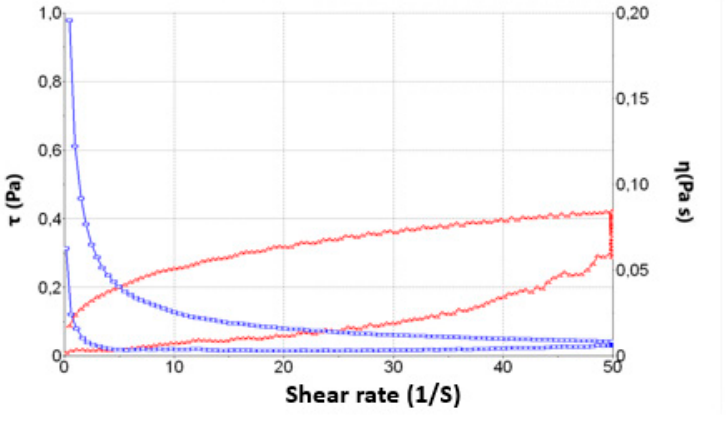
Figure 6. Rheological behaviour of PF-NLCs-N6.